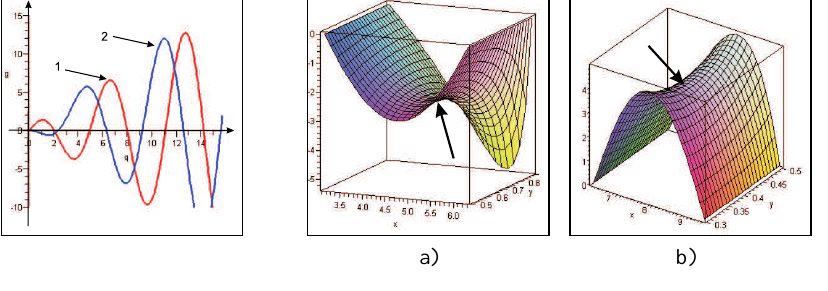
Figure 3. Functions h 1 (1) Figure 4. Function (cid:13) 1+ ( x; (cid:24) )